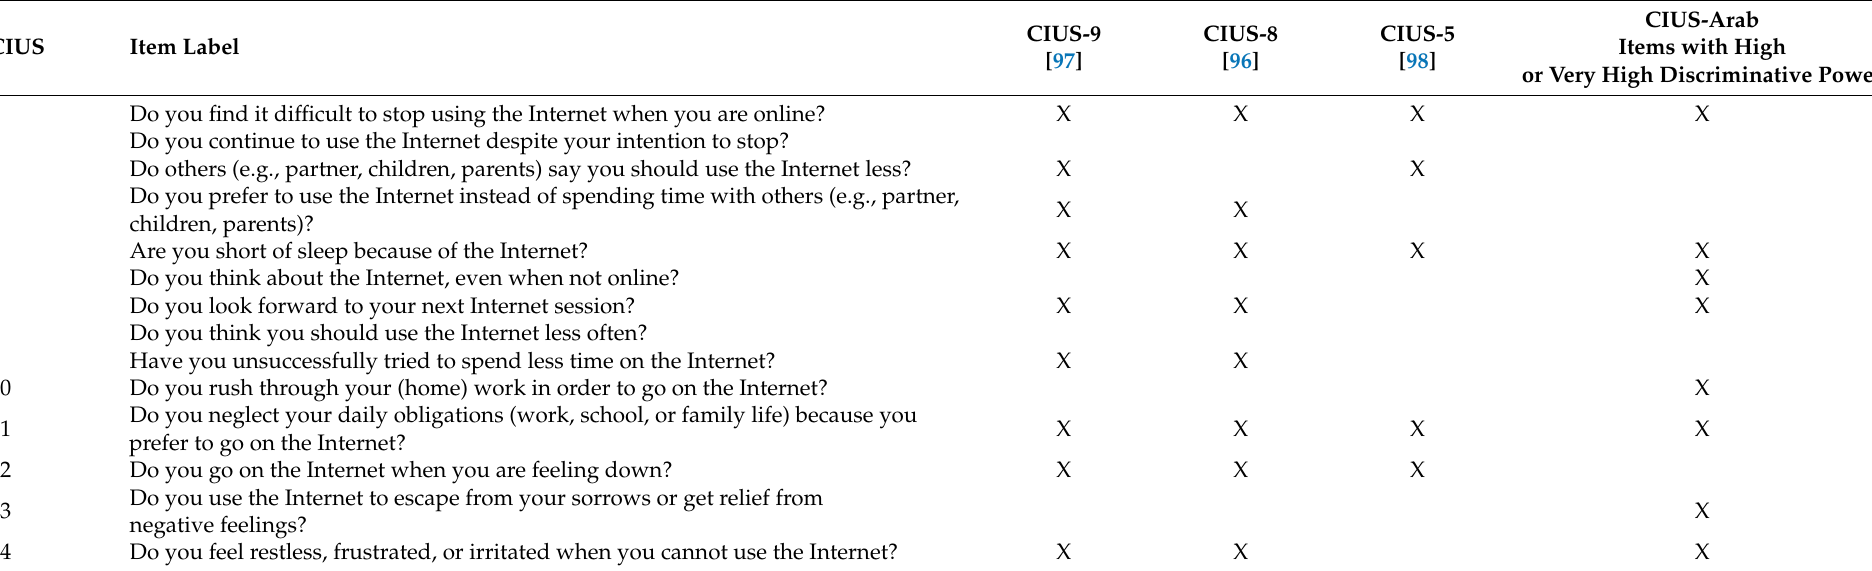
Table 4. Items with high or very high discriminative power (CIUS-Arab) in comparison with the items of some CIUS short versions.